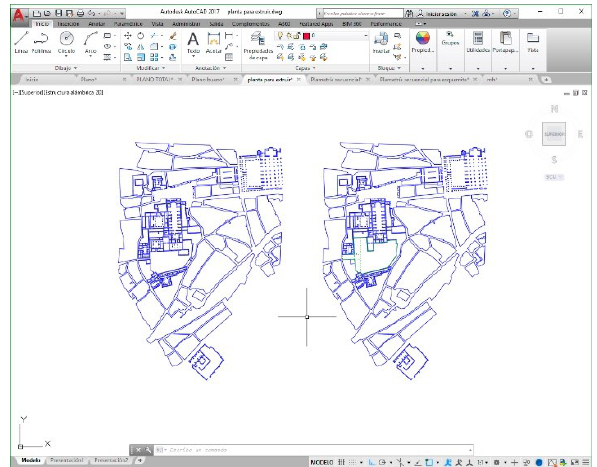
Figure 2. Screenshot of the 2D drawings made for the Plaza Nueva case. To the left, the planimetry of the old convent of San Francisco. To the right, the unrealised project by Cayetano Vélez. (The authors, 2017)